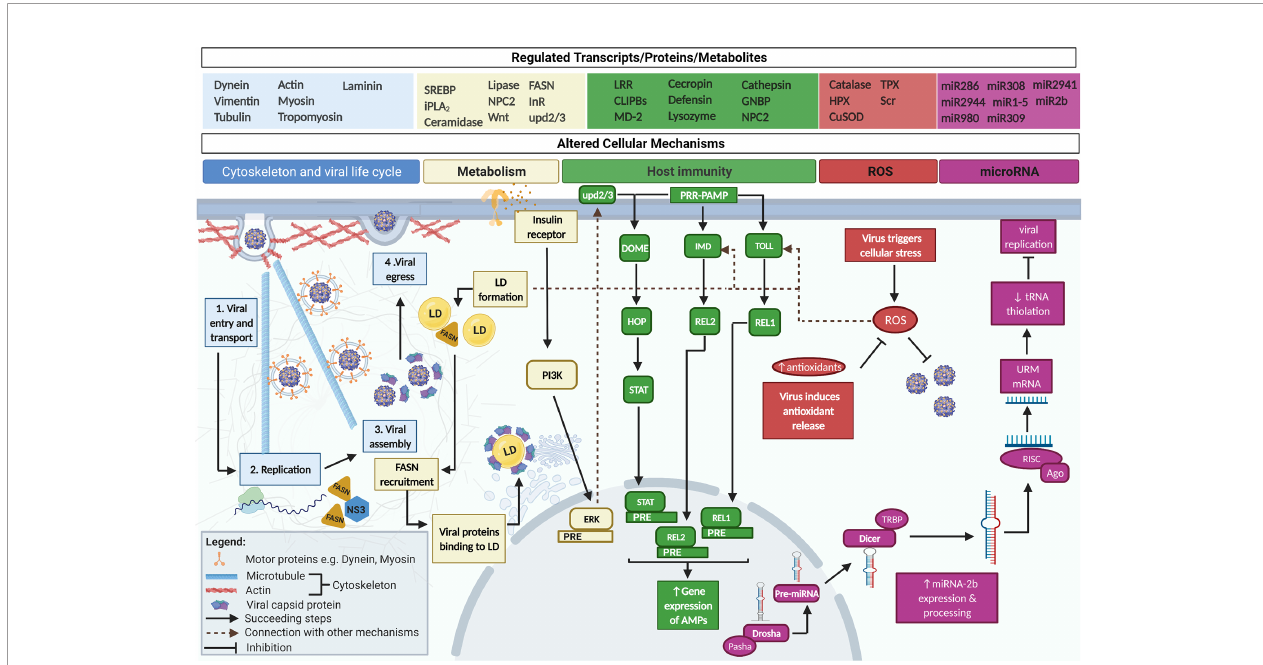
FIGURE 1 | Ae. aegypti 's cellular mechanisms are affected by arboviral infection. Arboviral infections alter Ae. aegypti ’ s genes, proteins, and metabolites to control the host ’ s cellular mechanisms. First, arboviruses utilize host cytoskeletal proteins (e.g. dynein and myosin) to facilitate their intracellular transport. Second, the need for host cell nutrients allows the virus to alter host lipid/cholesterol and also triggers the formation of LD. LD can enhance host immunity via Toll/Imd, can aid viral replication through fatty acid synthase (FASN) recruitment by DENV NS3, and can be integrated into viral capsids. The activation of insulin receptor is also said to signal antiviral mechanisms i.e. ERK and JAK/STAT via upd2/3. Following activation of host immunity, antimicrobial peptides are produced. Third, arboviruses cause Ae. aegypti to produce elevated ROS. ROS can either directly harm invading arboviruses or activate the Toll immune mechanism. Arboviruses respond to the effects of ROS by upregulating antioxidant release which functions to lower down ROS in the cell. Fourth, miRNA-2b is initially processed inside the nucleus and brought out to the cytoplasm for further cleaving. A seed sequence produced from the RISC complex binds to URM, its target mRNA leading to the suppression of tRNA thiolation and inhibition of viral